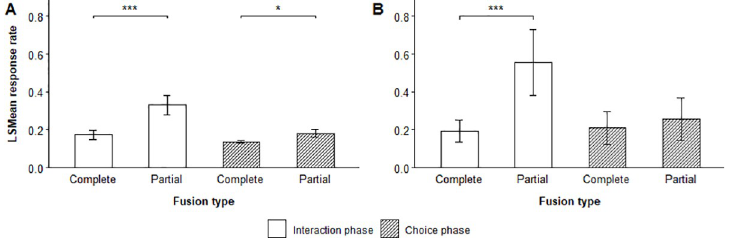
Fig 2. Effect of fusion type on response rate. LSMean ( ± SE) contact call response rate emitted by focal flocks during the interaction and choice phase of (A) male-male and (B) male-female trials where flocks made partial or complete fusions with a stimulus individual. Significant pairwise comparisons are indicated with